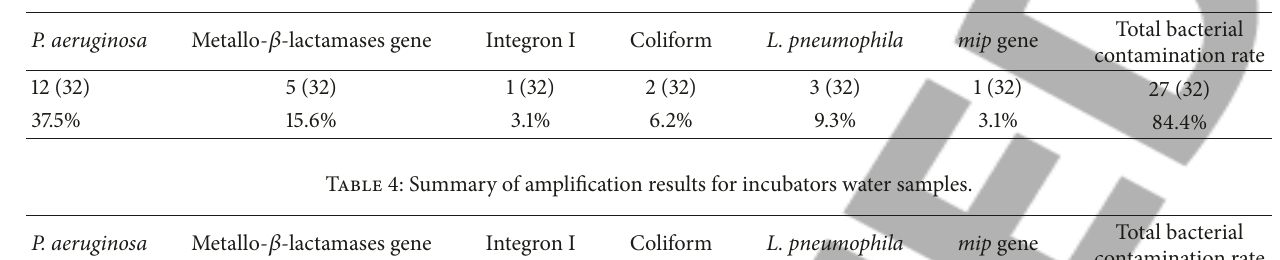
Table 3: Summary of amplification results for warm water samples.